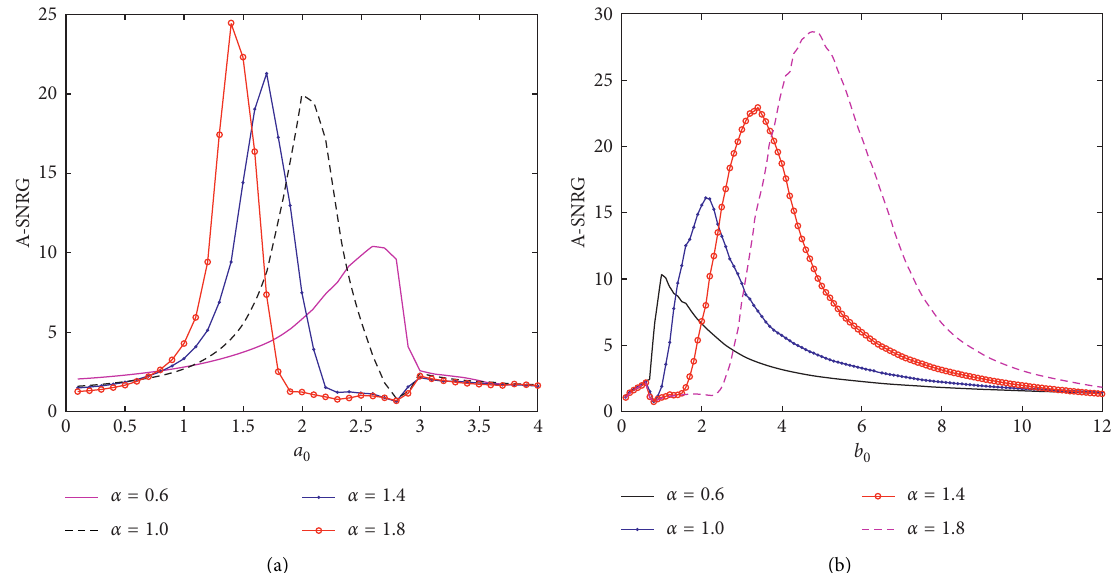
Figure 7: A-SNRG of SR with asymmetric depth of potential well as a function of the potential function parameter. (a) a